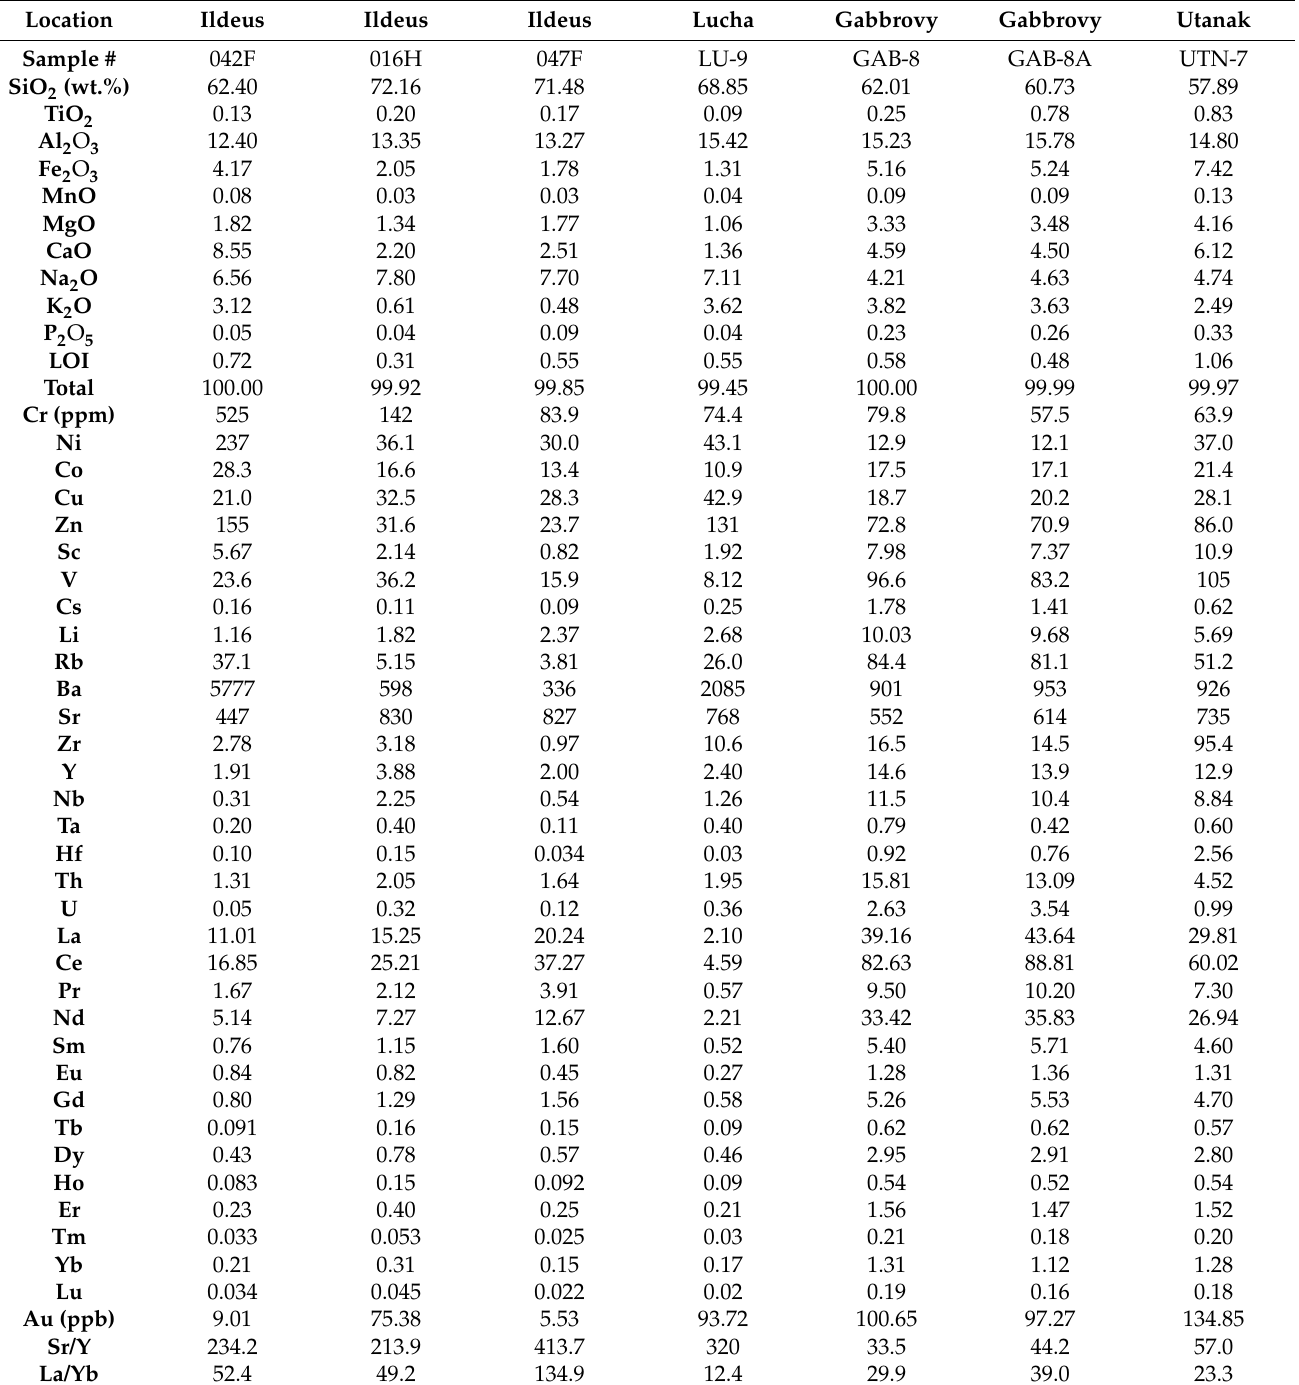
Table 7. Representative compositions of Cretaceous (117–114 Ma) adakites from the Stanovoy Suture Zone